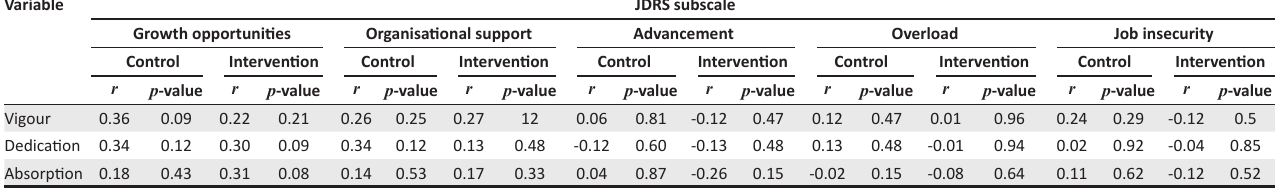
TABLE 6: Correlation matrix: Job Demands-Resources Scale subscales and Utrecht Work Engagement Scale-17 subscales. Variable